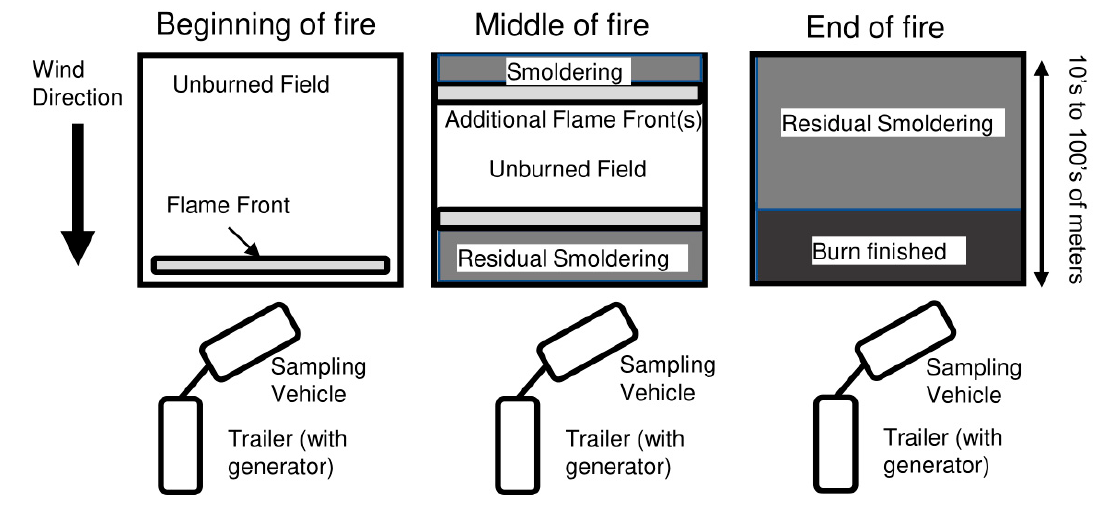
Figure 1. Diagram of sampling arrangement during burns, illustrating the relationship between the evolving flame front, the sampling trailer, and the generator relative to the wind direction.